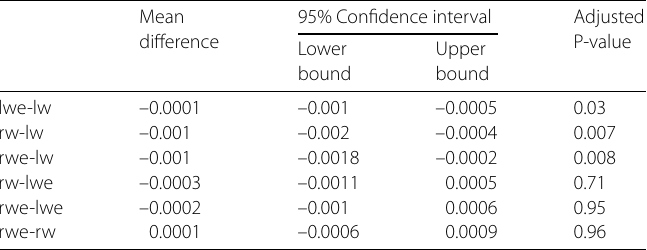
Table A8 Multi-group mean comparisons of harm avoidance in 25% sample size data using Tukey’s HSD test